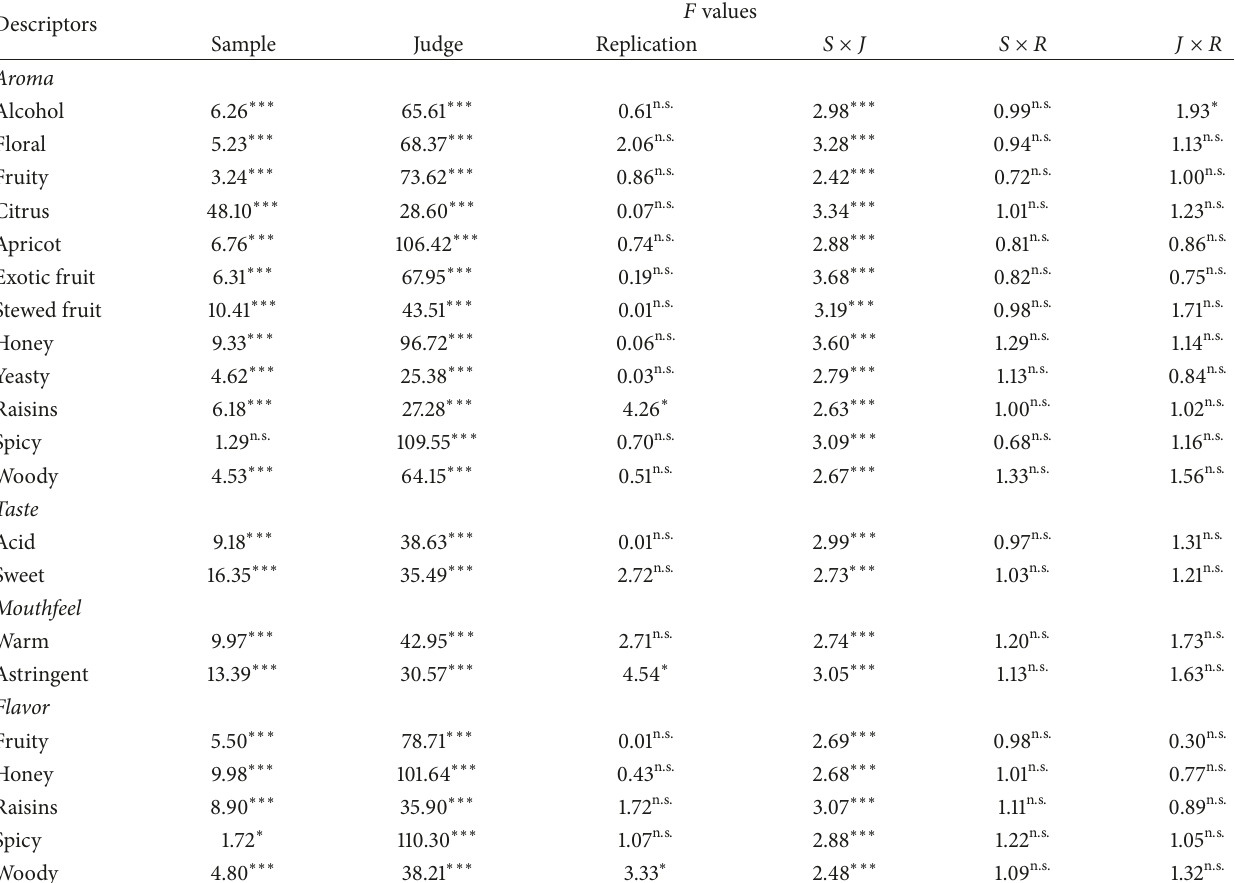
Table 2: Influence of samples (21), judges (8), and replications (3) on the twenty-one descriptors of wine samples.